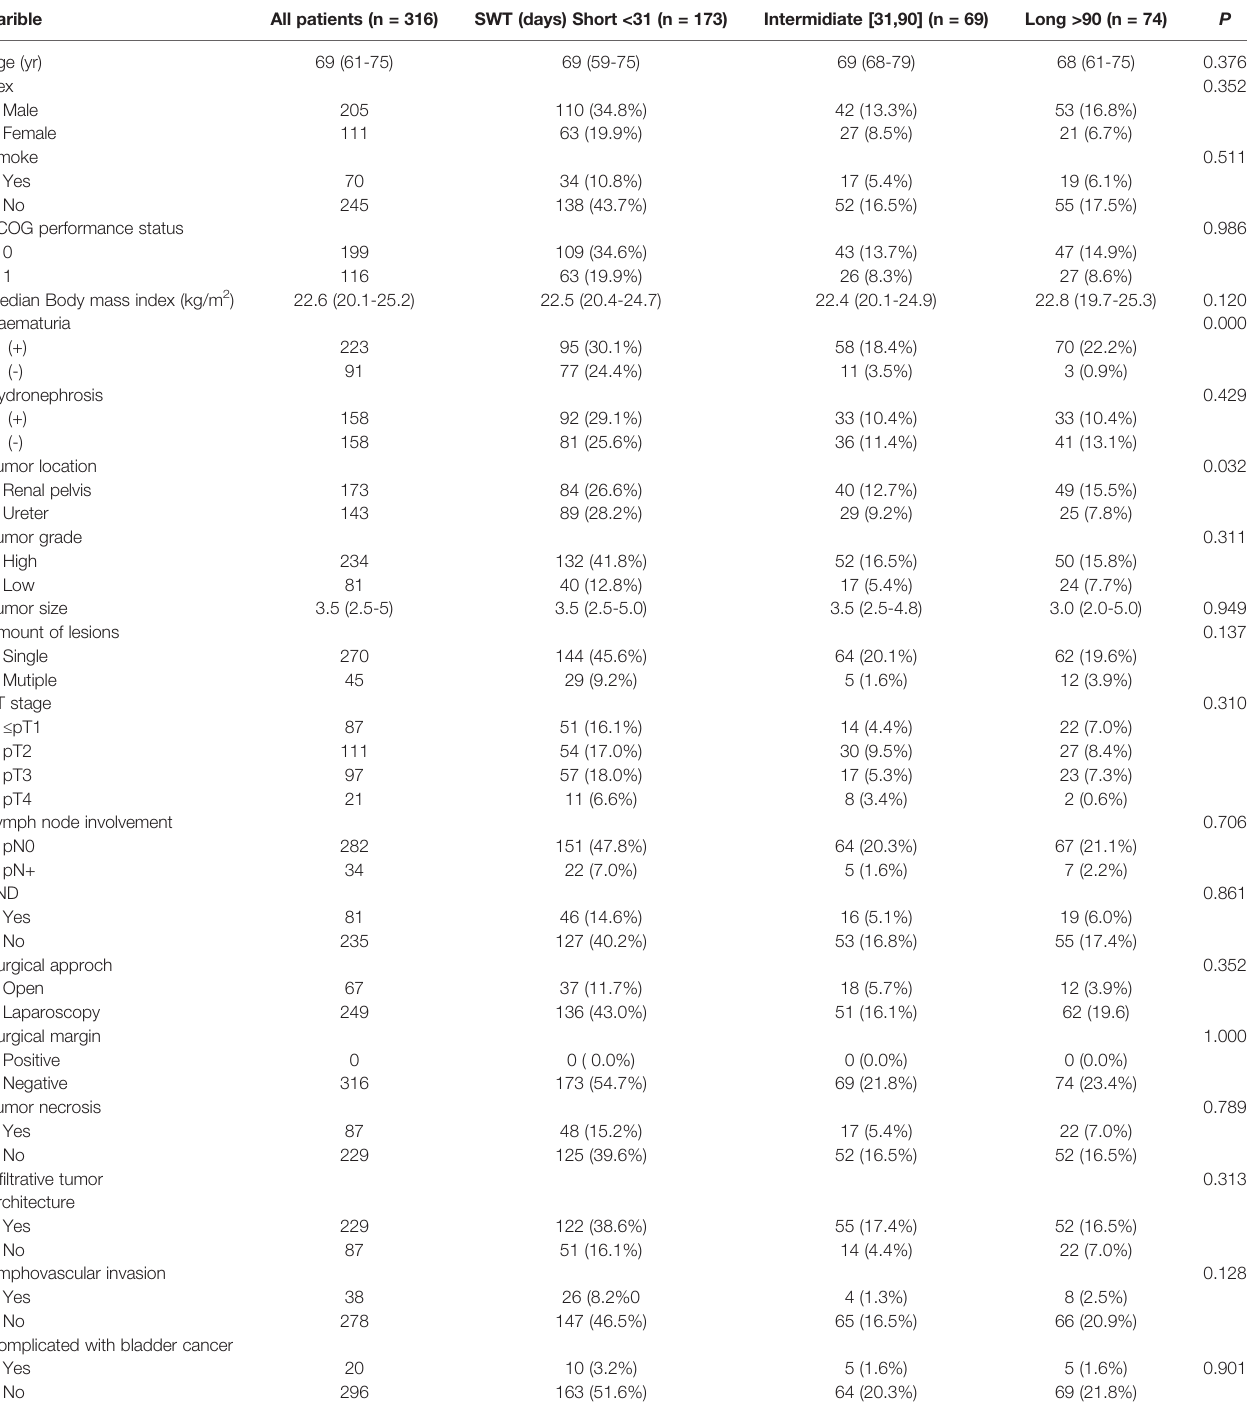
TABLE 1 | Clinical characteristics of patients in the short-, intermediate-, and long-wait groups. Varible All patients (n =